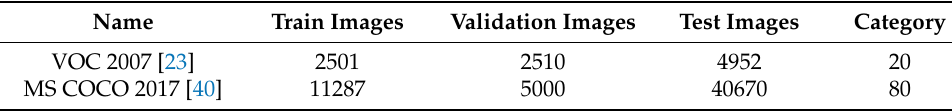
Figure 6. Flow diagram of the training and detection process [43]. Table 1. Dataset statistics of PASCAL VOC and MS